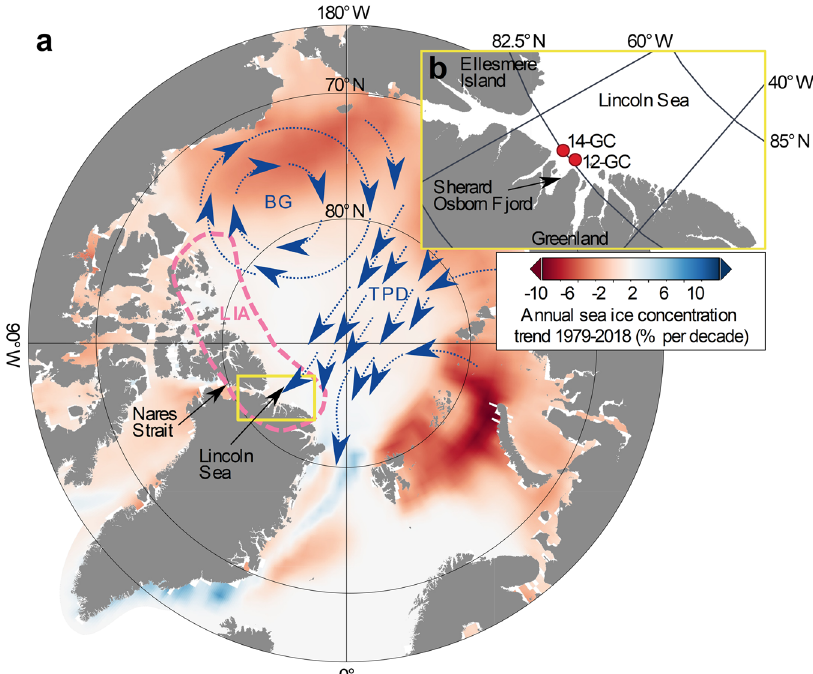
Fig. 1 Sea-ice concentration trend in the Arctic Ocean and core locations in the Lincoln Sea. a Map of the Arctic Ocean including the annual sea-ice concentration trend from 1979 to 2018 94 (and references therein) and the major surface circulation features, the Transpolar Drift (TPD) and Beaufort Gyre (BG) (dashed blue arrows). The dashed pink line outlines the region of the last ice area (LIA) that lies within the Arctic Ocean proper. The trend in sea-ice concentration is shown as % per decade, i.e. the decrease/increase of sea-ice concentration per 10-years for the period from 1979 to 2018. b Close-up of the Lincoln Sea (yellow rectangle in a ) including locations of core sites Ryder19-12-GC1 (12-GC) and Ryder19-14-GC1